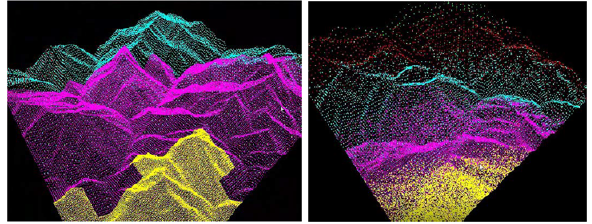
Figure 4. dLoD(left) and